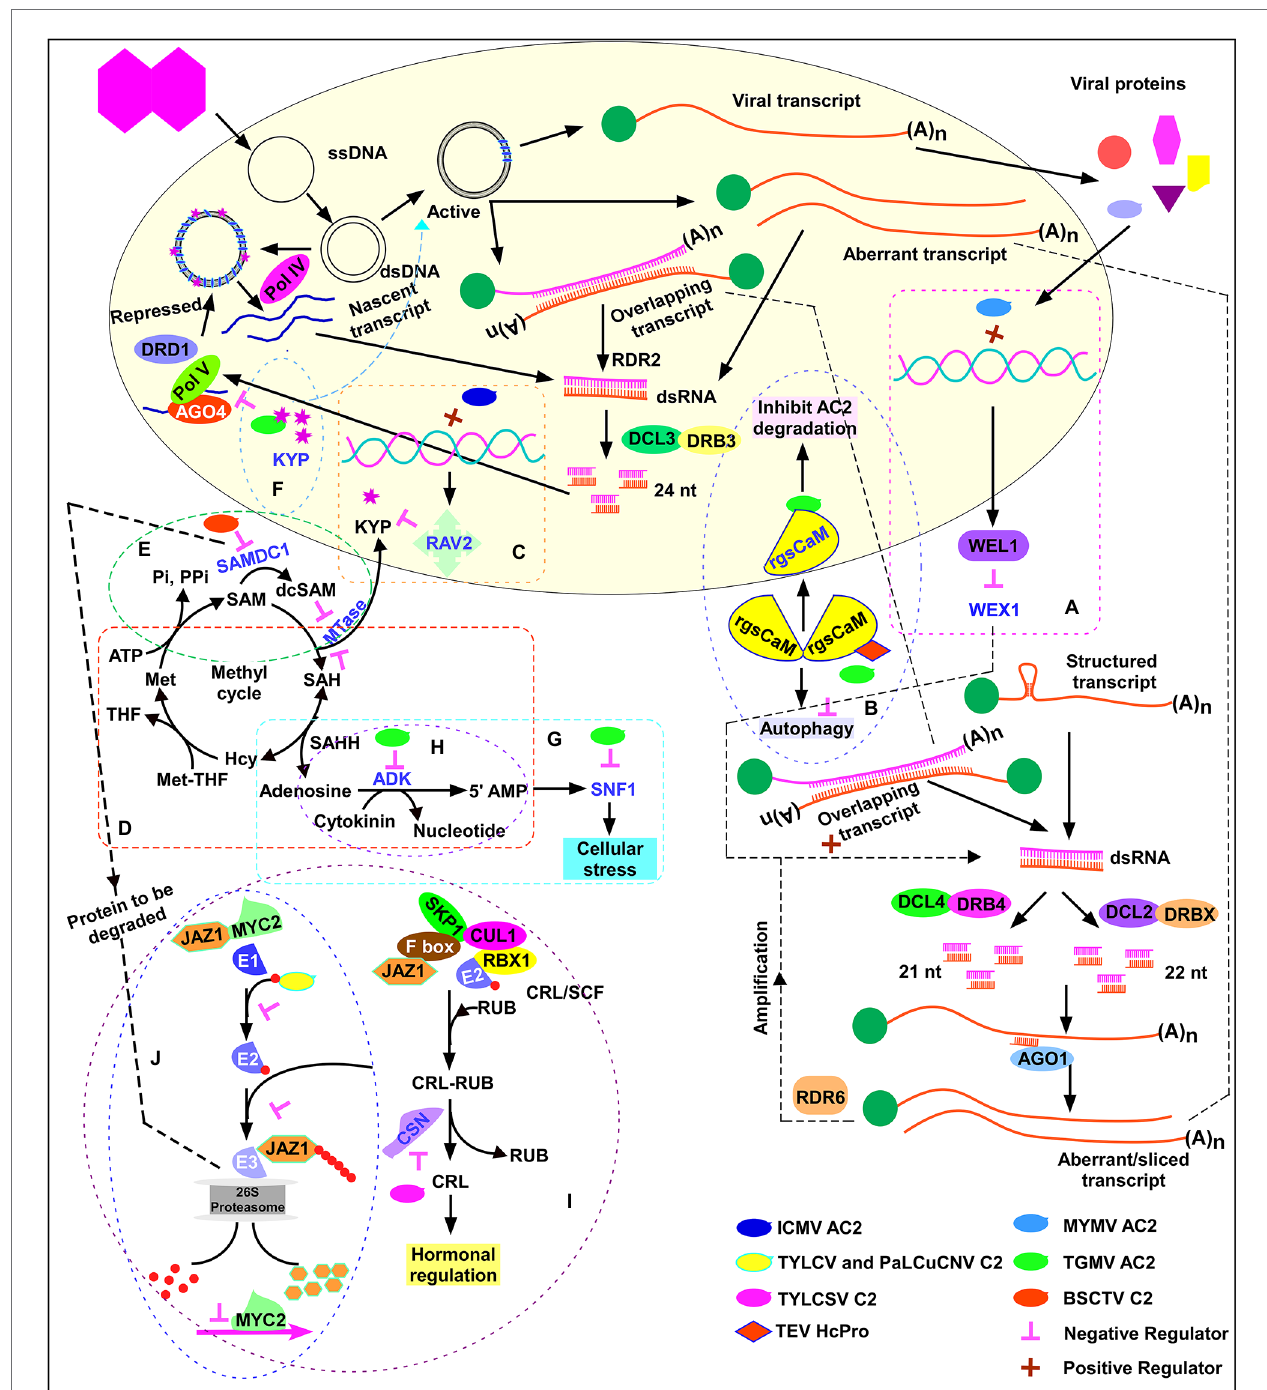
FIGURE 4 | AC2-mediated suppression of host defense mechanism. Activation domain-dependent mechanism: suppression of PTGS by activating the host silencing suppressors (A) Werner’s exonuclease-like 1 ( WEL1 ) by MYMV AC2, (B) calmodulin-like protein by TGMV AC2, and (C) RELATED TO ABI3 and VP1 (RAV2), transcription repression and downregulation of H3K9 histone methyltransferase KRYPTONITE (KYP) by Indian cassava mosaic virus (ICMV) AC2. Activation domain-independent mechanism: (D) The methyl cycle and suppression of PTGS/TGS by inactivating adenosine kinase by TGMV AC2 and BCTV C2. (E) Suppression of PTGS by stabilizing S-adenosyl methionine decarboxylase1 by BSCTV C2. (F) Suppression of TGS by inhibiting KYP enzymatic activity by TGMV and CaLCuV AC2 binding. (G) Suppression mediated by inactivation of SNF1 kinase by TGMV AC2 and BCTV C2. (H) Suppression mediated by elevation of cellular cytokinin levels by TGMV AC2 and C2 of SCTV. (I) Suppression mediated by inhibition of jasmonate signaling pathway by C2 of TYLCSV. (J) Suppression mediated by competitive binding of C2 of TYLCV and PaLCuCNV to